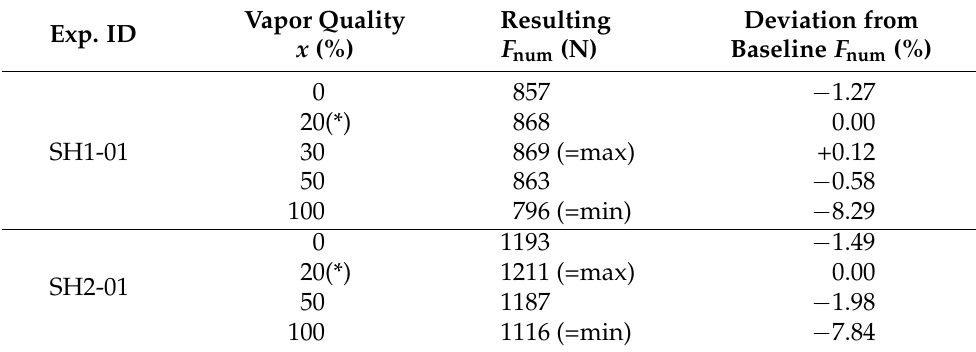
Table 11. Effect on F num when varying the oxidizer inlet vapor quality x